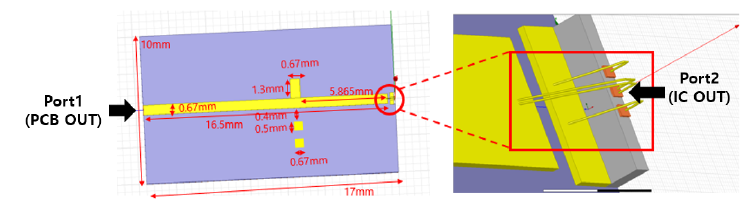
Figure 28. Wire bonding matching circuit applying stub circuit.